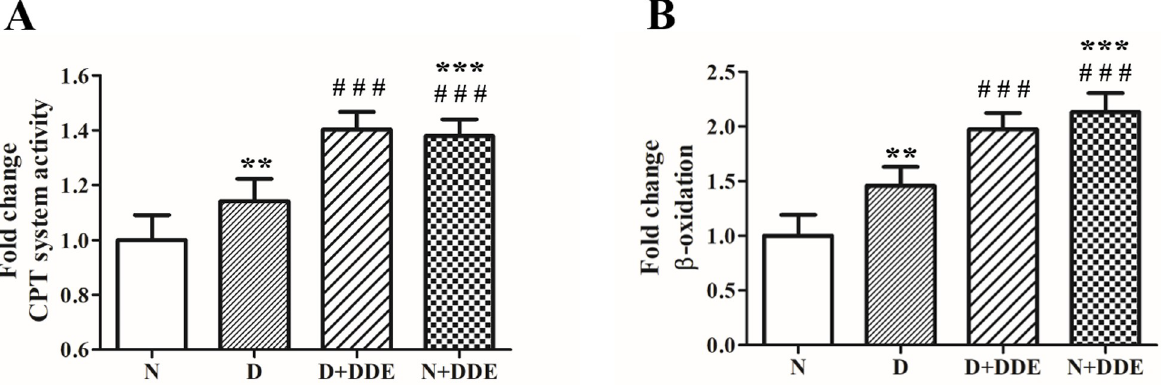
Fig 1. Hepatic mitochondrial lipid utilization. Fatty acid utilization capacity was tested measuring both CPT system activity (A) and β -oxidation rate (B). Data are reported as means ± ES of 8 different rats for each group. Significant of differences is shown: �� p < 0 . 01 vs. N; ��� p < 0 . 001 vs. N; ## p < 0 . 01 vs. D; ### p < 0 . 001 vs.